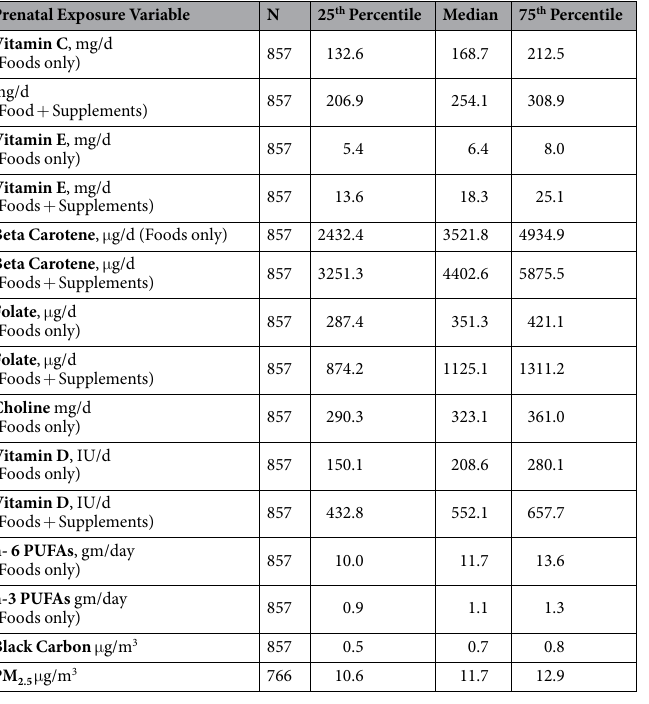
Table 2. Distribution of Prenatal Exposure Variables (Nutrient Intakes from Foods and Supplements and Air Pollutant